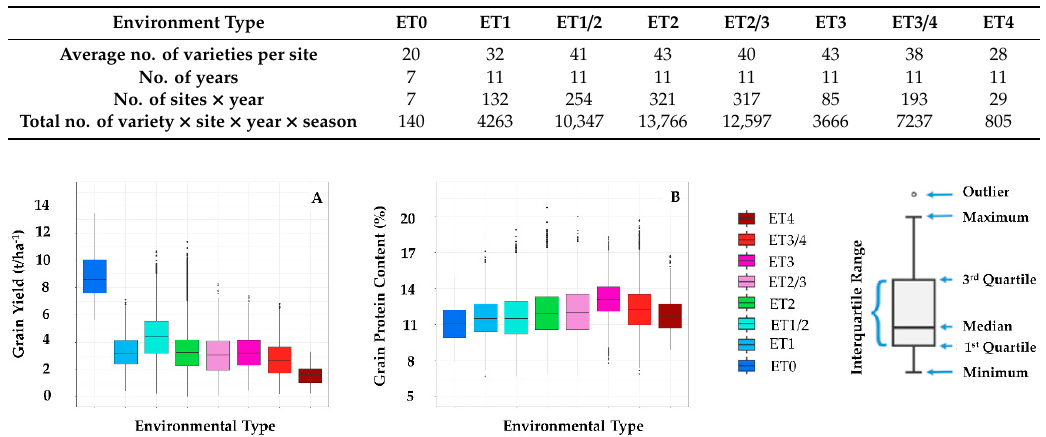
Figure 1. Grain yield ( A ) and grain protein content ( B ) of all 215 varieties in the NVT dataset. Total numbers of variety × site × year × season were 52,822 collected from 206 sites. Name of varieties is listed in Supplementary Data S1. Boxes refer to the 25th (first quartile), 50th (median), and 75th (third quartile) percentile of